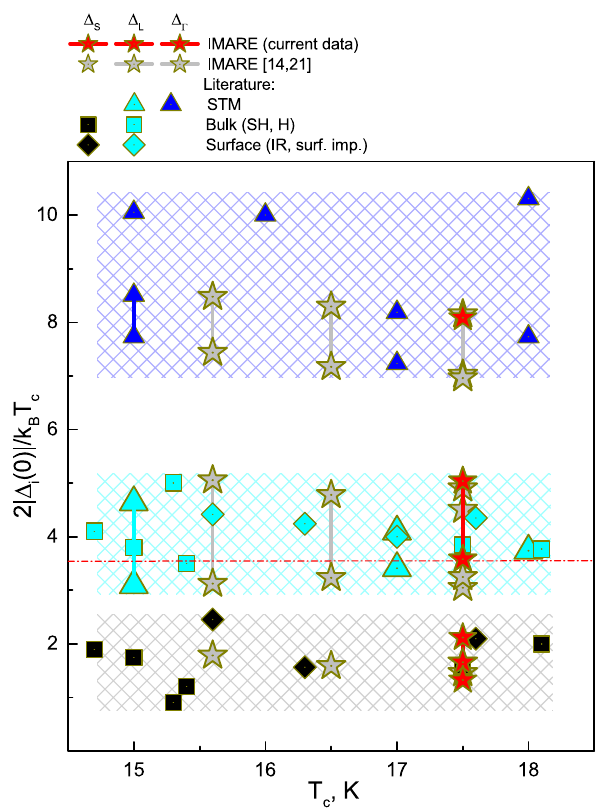
Fig. 7 The characteristic ratios 2 Δ i ( 0 )∕ k B T c versus critical tem- perature T c obtained in Li 1 − 𝛿 FeAs single crystals. The current data obtained using IMARE spectroscopy (Figs. 2, 4) are shown by red stars, our earlier data detailed in [14, 21]—by gray stars. The char- acteristic ratios estimated for the large superconducting gap (blue symbols), middle gap (cyan symbols), and the small gap (black symbols) using STM (triangles) [22–26], bulk techniques (squares) [27–32], and surface probes (rhombs) [33, 34] are shown for com- parison. Dashed areas cover the 2 Δ i ( 0 )∕ k B T c ranges for clarity, the vertically connected symbols illustrate the gap anisotropy. Dash- dot line shows the weak-coupling BCS limit